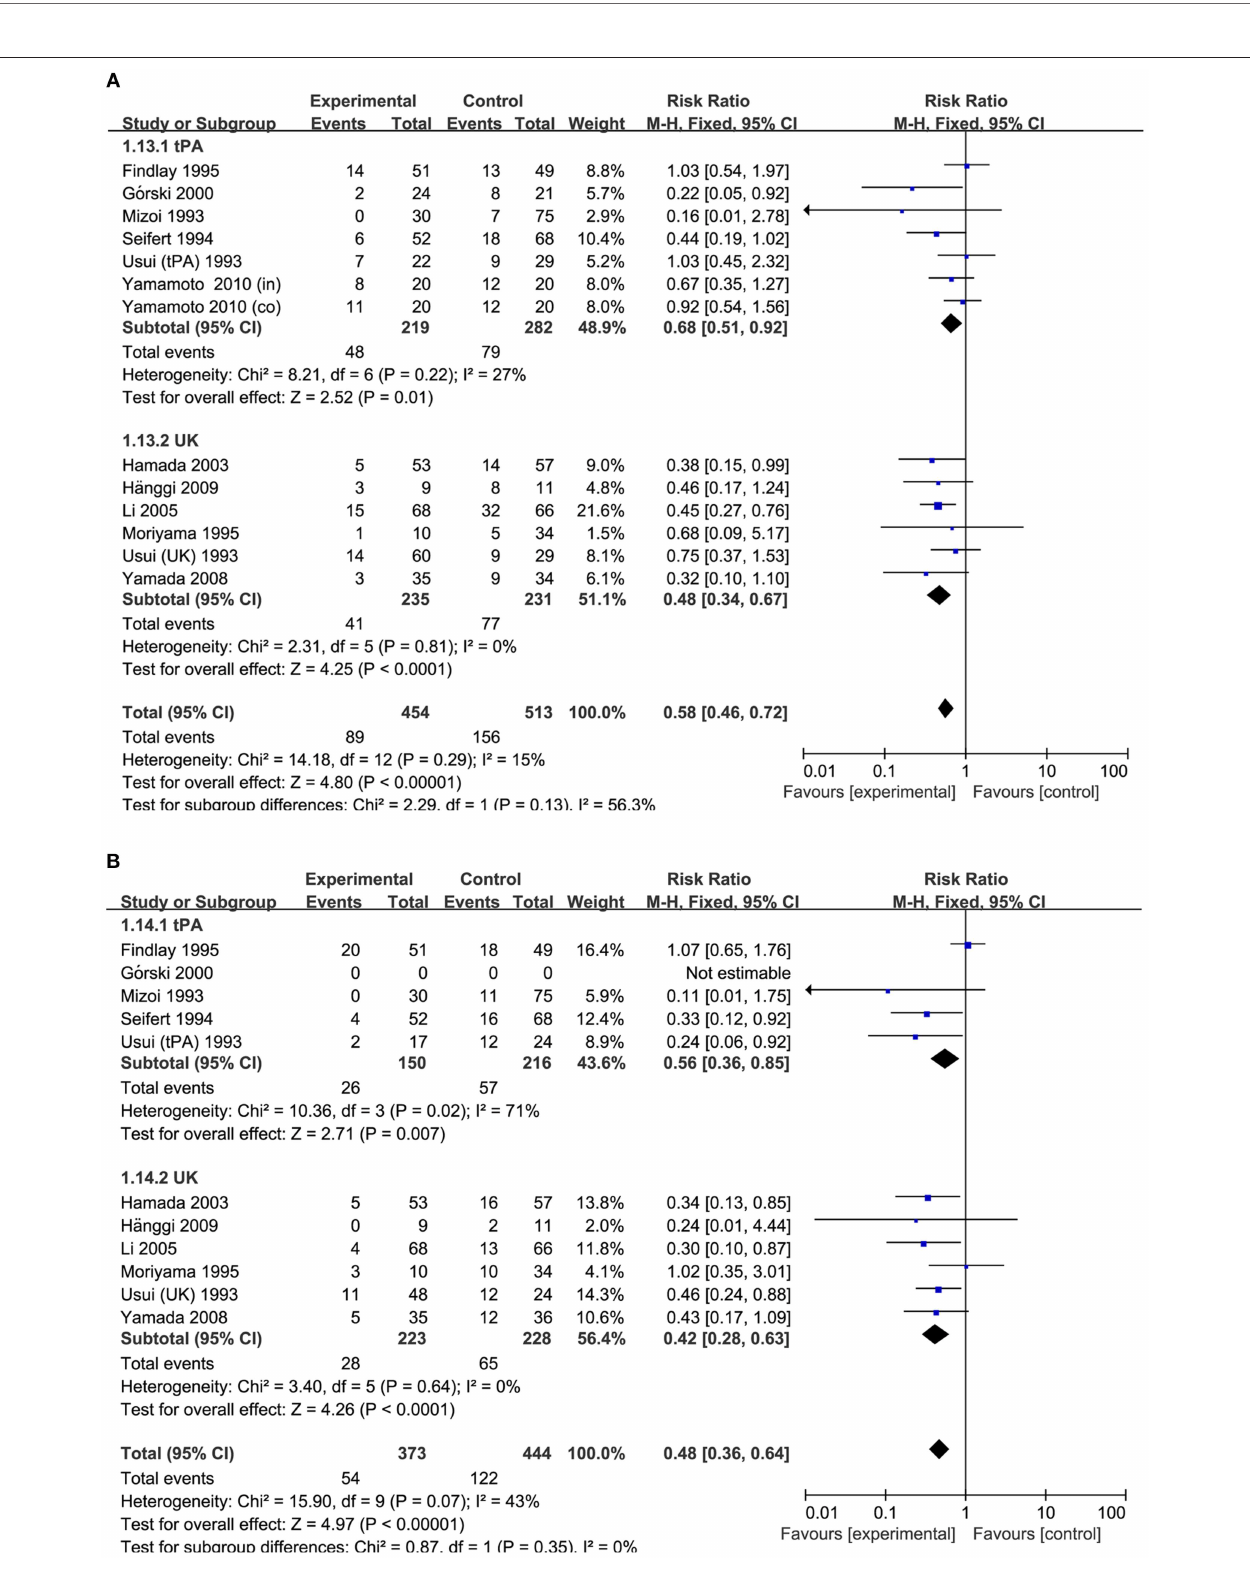
FIGURE 5 | Meta-analysis of associations between intracisternal fibrinolysis and the risk of poor neurologic recovery (A) or the incidence of DIND (B) in patients with aSAH (stratified by types of thrombolytic agents). aSAH, aneurysmal subarachnoid hemorrhage; CI, confidence interval; M–H, Mantel–Haenszel method; UK, urokinase; tPA, tissue plasminogen